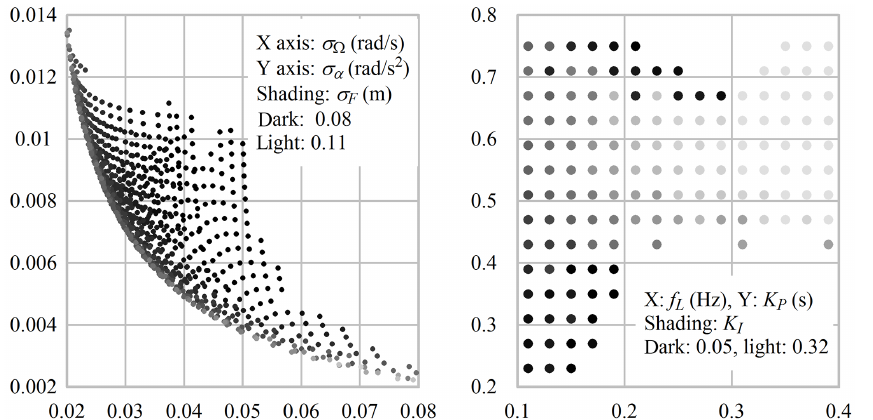
Figure 17. Points on the Pareto front, plotted according to the objectives (on the left) and the control tuning parameters (on the right). The wind speed is 16ms − 1